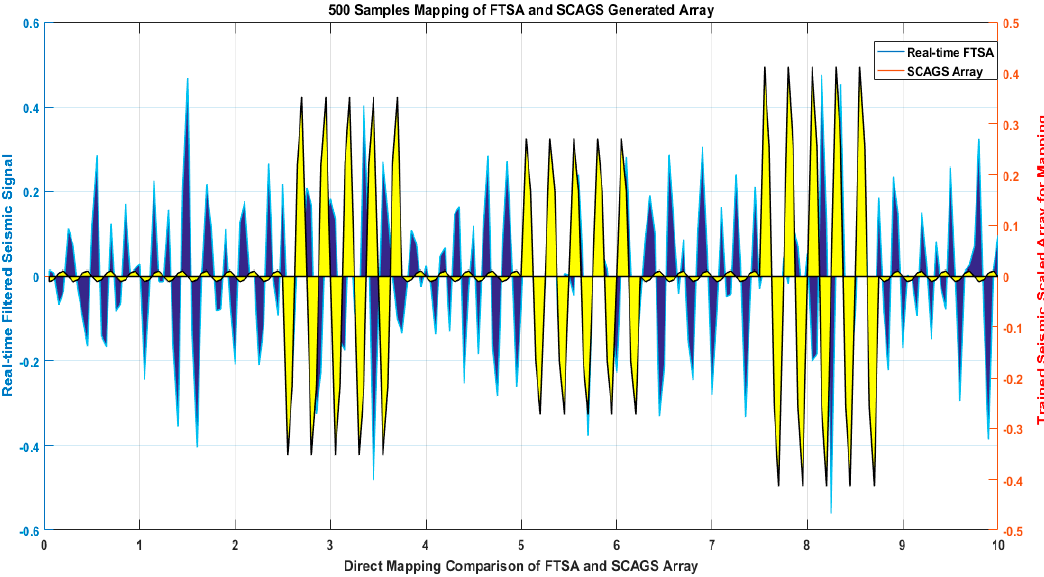
Figure 7. The scaling coefficients array generation sequence (SCAGS) mapping for SP2.